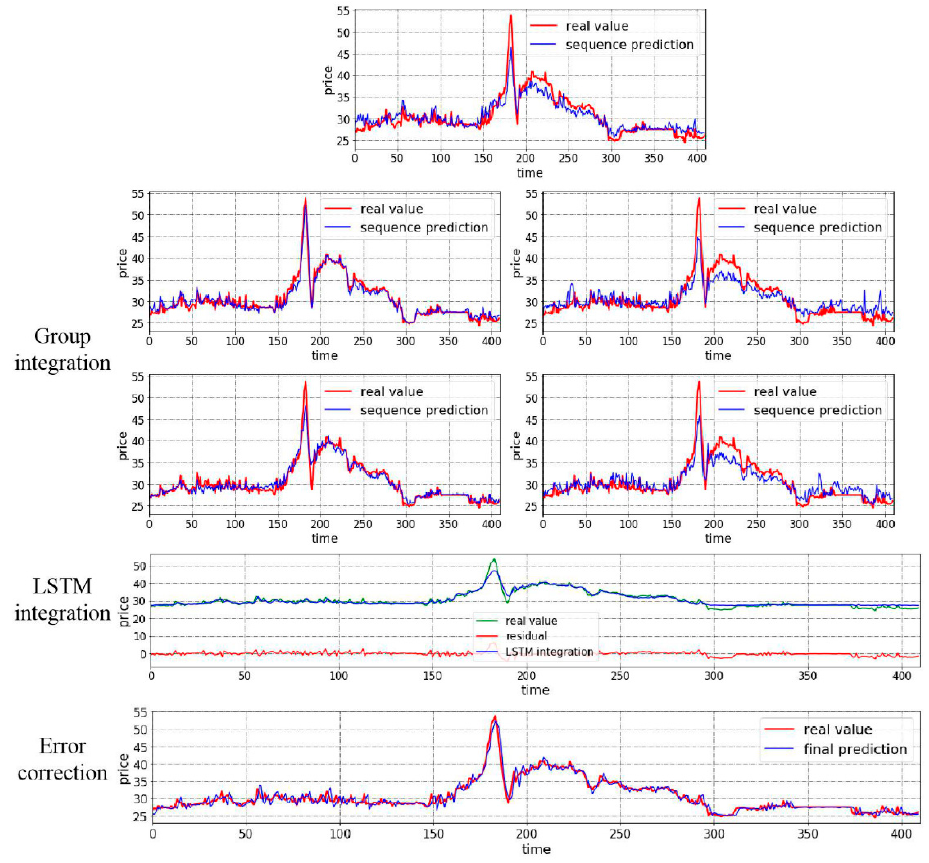
Figure 7. The point prediction of case 2.